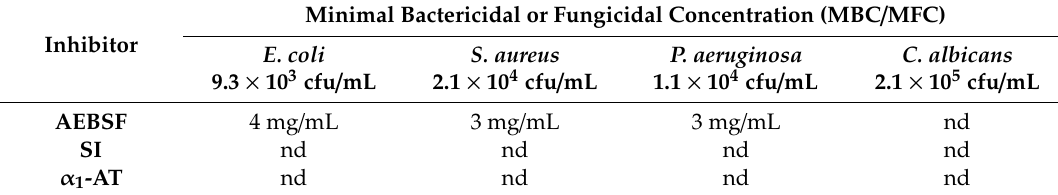
Table 4. MBC / MFC values for three serine protease